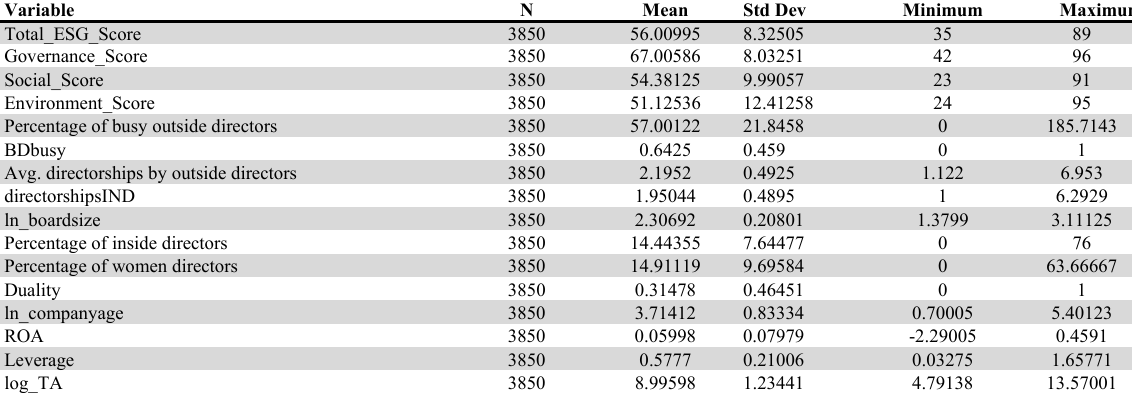
Descriptive Statistics